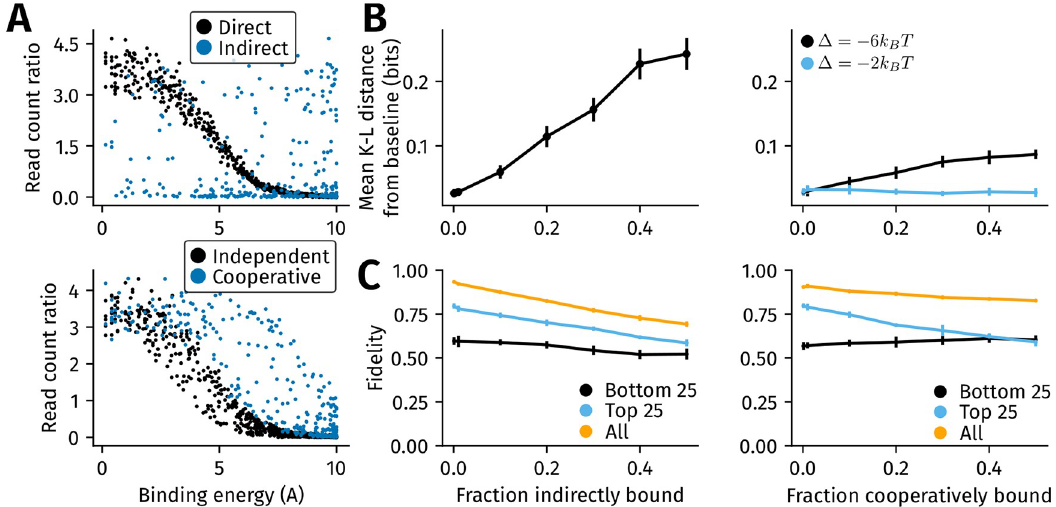
Fig 4. The relative impact of the inclusion of indirectly bound and cooperatively bound locations on motif inference and ChIP- seq fidelity. (A) Indirect binding and cooperative binding between TFs A and B are simulated as described in Methods. The scatter plots show the read counts from simulations where 30% of genomic locations are indirectly bound (top panel) or cooperatively bound (bottom panel, interaction energy ( Δ ) set to − 6 k ). In the top panel, the binding energy of A shown on the x-axis refers to B T the energy with which A would bind a location if it were in direct contact with DNA. The binding energies of A and B are sampled from a power law (with exponent 0.5) over a range of [0, 10 k ]. (B) Inclusion of indirectly bound locations [left] distorts the B T inferred motif more than the inclusion of cooperatively bound locations [right panel]. The change in the average K-L distance per base between the baseline motif and inferred motif (y-axis) is plotted against the fraction of indirectly bound regions [left] or cooperatively bound regions [right] on the x-axis. In the right panel, the cooperative interaction energy with the second TF is varied between − 6 k B T (black) and − 2 k B T (blue) (orange). The error bars are the standard deviation obtained from ten replicates of simulation. (C) Indirect binding has a greater impact on ChIP-seq fidelity than cooperative binding. The variation with fidelity and the fraction of indirectly bound [left] or cooperatively bound [right] locations is shown. The fidelity is calculated across all genomic locations (black), the top 25th percentile (blue) and the bottom 25th percentile (orange) of binding sites. The error bars are the standard deviation obtained from ten replicates of